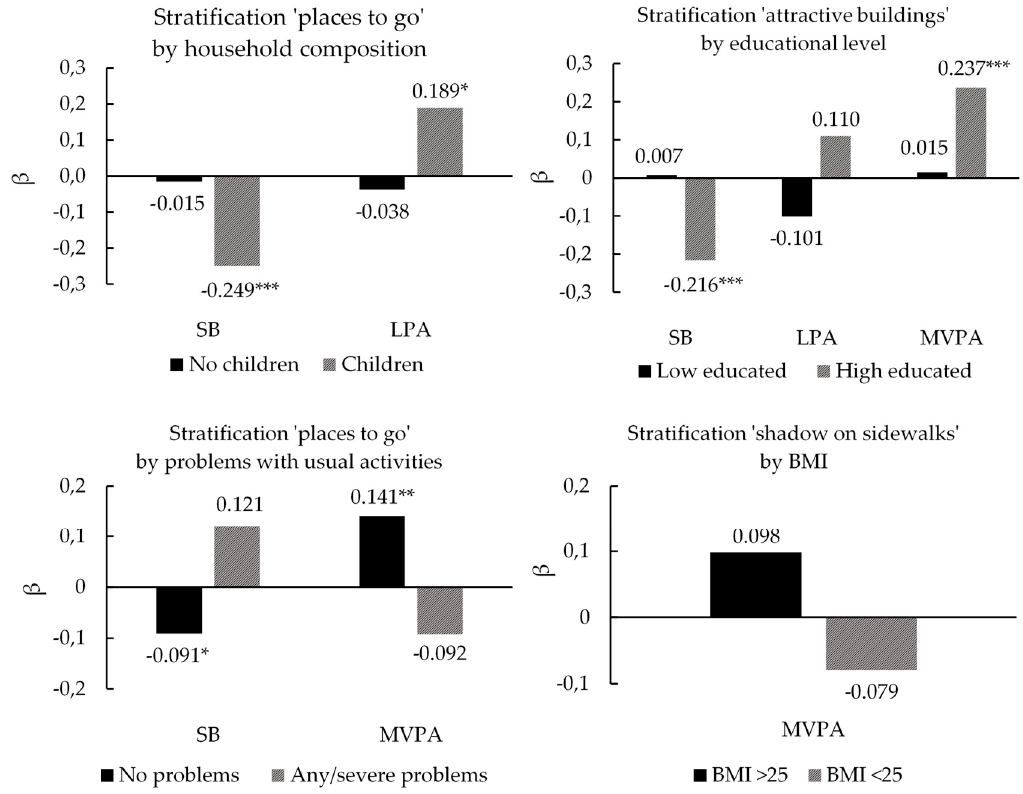
Figure 1. Interactions between personal characteristics (socio-demographic and HRQoL) and PA-facilitating built environmental characteristics. * = p < 0.05; ** = p < 0.01; *** = p < 0.001.